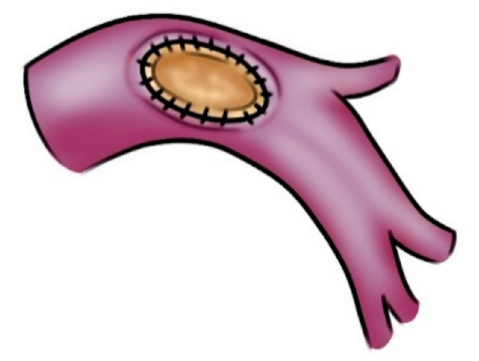
Figure 2. Left PA reconstruction with a patch of heterologous pericardium.